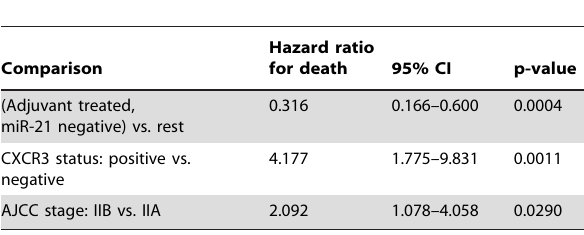
Table 5. Multivariate analysis of adjuvant treated patients: overall survival.